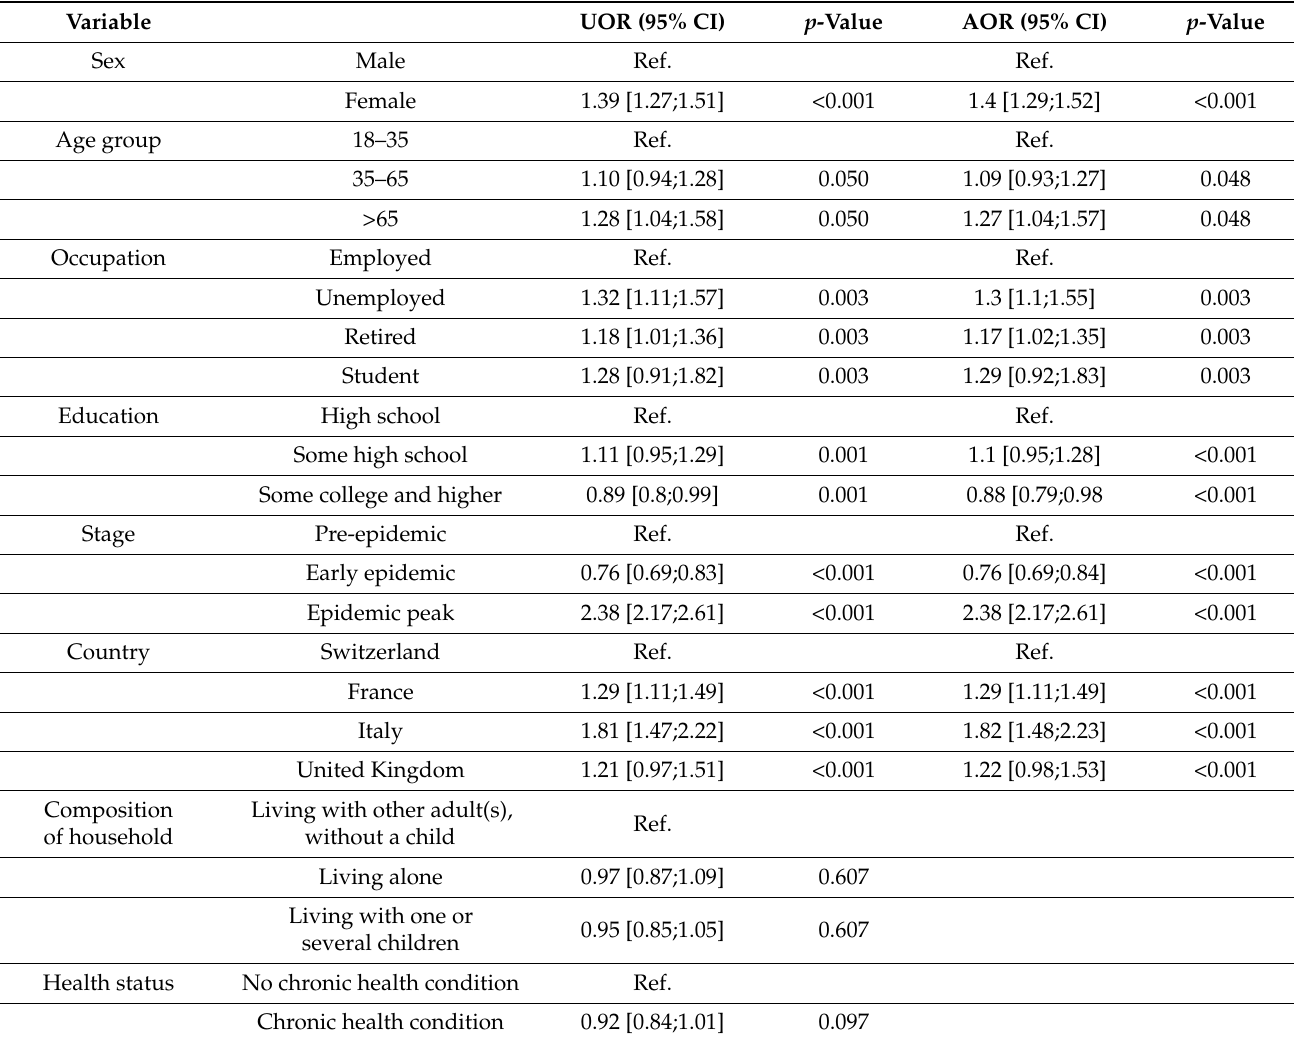
Table 4. Personal and contextual determinants of unrealistic optimism related to SARS-CoV-2 infection: unadjusted and adjusted odds ratio (UOR, AOR), 95% confidence interval, and p -value.